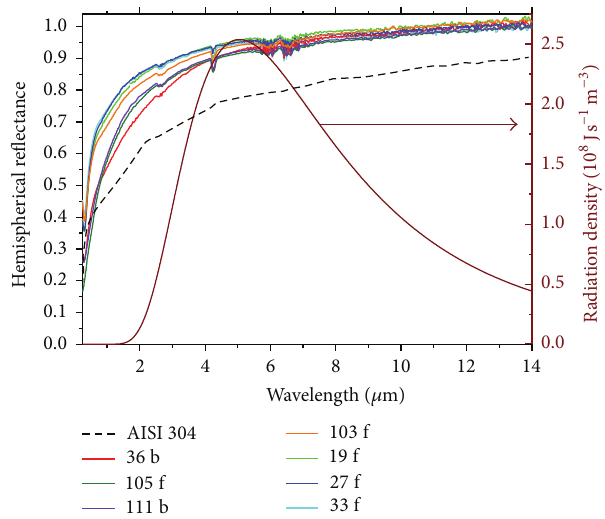
Figure 5: Comparison of reflectance spectra of the bare substrate (AISI 304), Wood-treated (36 b, 105 f, 111 b), and Watts-treated samples. In the picture, the blackbody spectrum at 300 ∘ C is also shown in wine